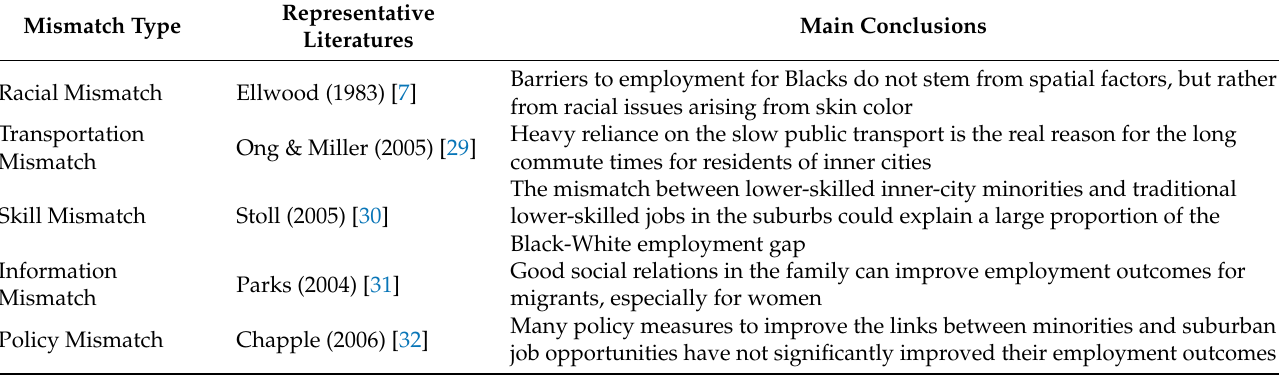
Table 1. Representative literatures of the various mismatch